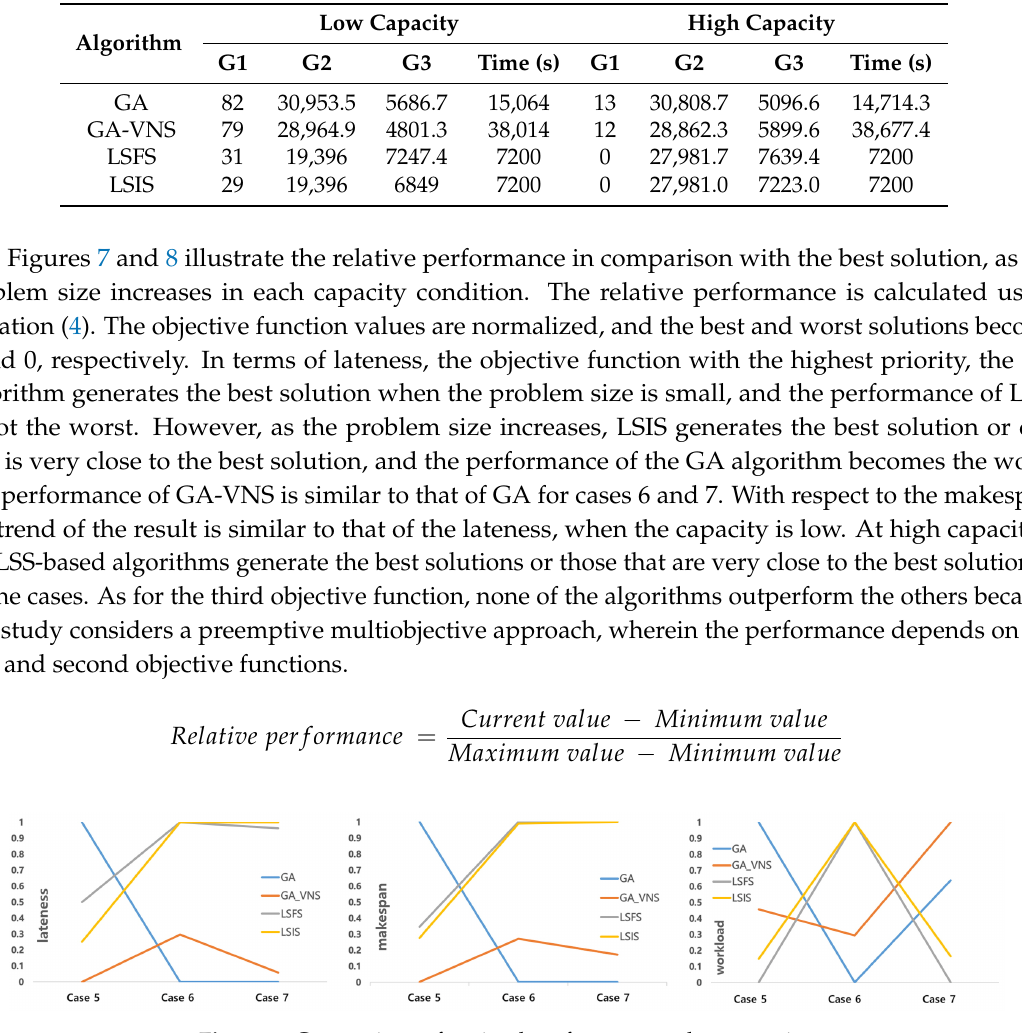
Figure 7. Comparison of optimal performance at low